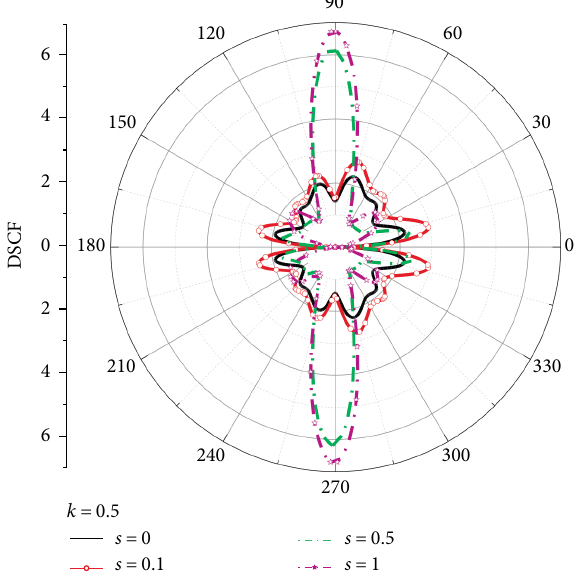
Figure 8: Distributions of DSCF around a square hole with various 𝑠 for 𝐾 = 𝜋 .